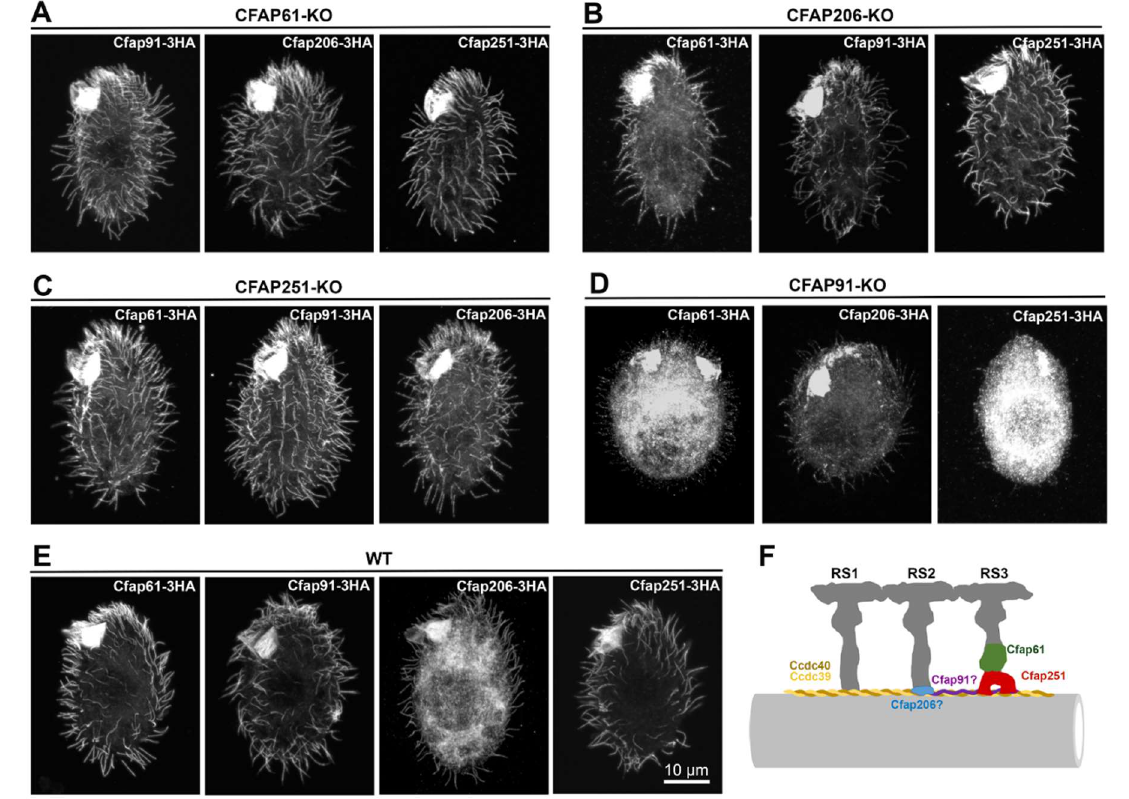
Figure 6. Ciliary localization of Cfap61, Cfap206, and Cfap251 is strongly reduced in cells lacking Cfap91. Immunofluorescence confocal images showing localization of the HA-tagged fusion proteins expressed under the control of respective native promoters in cells with deletion of ( A ) CFAP61 , ( B ) CFAP206 , ( C ) CFAP251 , or ( D ) CFAP91, and in ( E ) wild-type cells. Note that only the presence of Cfap91 is required for the ciliary localization of other studied Cfap proteins. ( F ) Schematic representation of the outer doublet microtubule (light grey) with three radial spokes (dark grey) showing confirmed (Cfap61, Cfap251) and putative (Cfap206 and Cfap91) localization of studied proteins. The proposed model explains why Cfap91 could be a key protein required for Cfap61, Cfap206, and Cfap251 stable docking. Ccdc39 and Ccdc40 (yellow and brown, respectively) are molecular ruler proteins, determining radial spokes position [49], Cfap206 (blue) is required for the stable assembly of RS2 [32], Cfap61 (green) and Cfap251 (red) form part of the RS3 stalk and arch-like structure at RS3 base, respectively [21], Cfap91 (purple) interacts with Ccdc39/Ccdc40 [12] and play a role in the stable assembly of RS2 and RS3-base proteins.